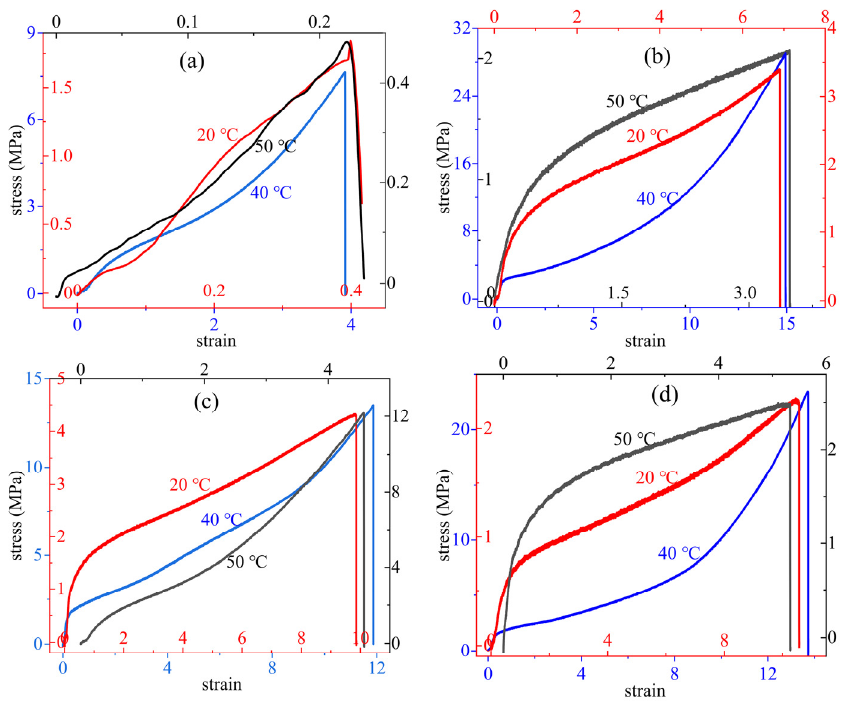
Figure 11. The strain-stress curves of four HTPE binder systems. ( a ) S-1, ( b ) S-2, ( c) S-3 and ( d ) S-4. Table 4. The σ m , ε b, and E exp of the S-1, S-2, S-3, and S-4 binder